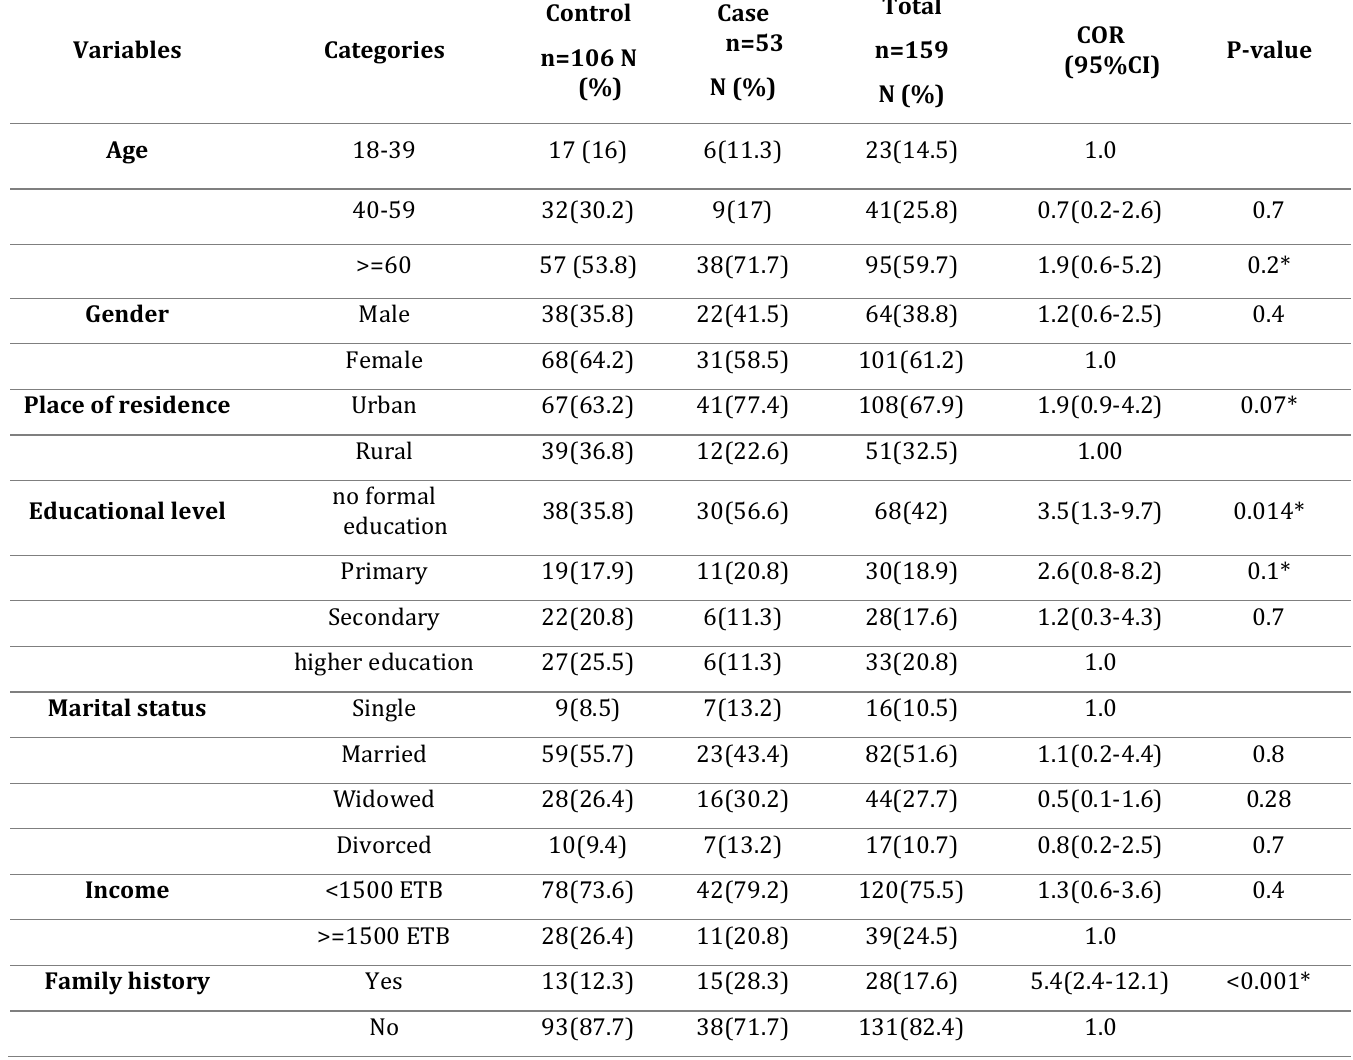
Table 1. Socio-demographic characteristics of study participants at Gondar University Referral Hospital during